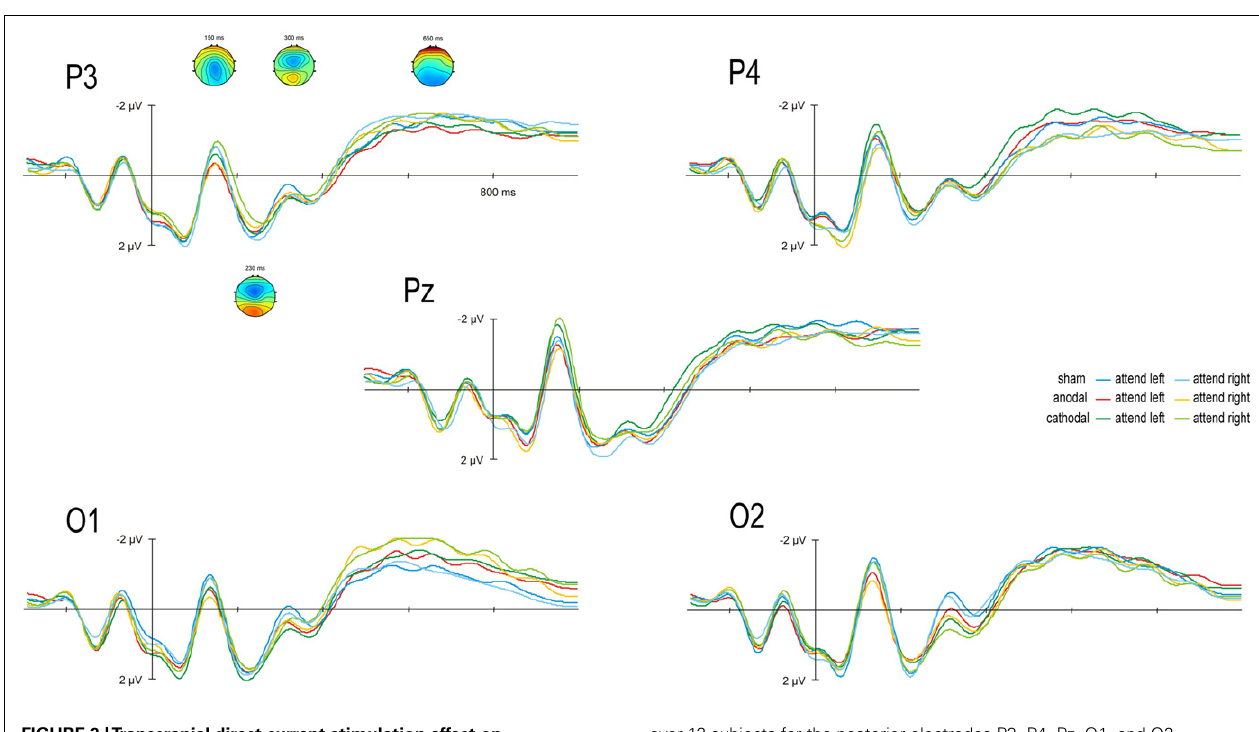
FIGURE 3 |Transcranial direct current stimulation effect on event-related potentials (ERPs): Grand average scalp-recorded ERPs are given for anodal, cathodal, and sham conditions for stimuli attended in the left and right hemifield. ERPs are averaged